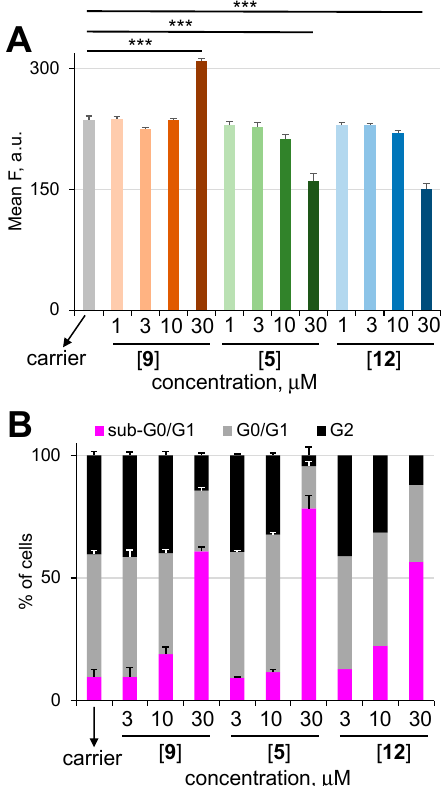
Figure 6. ( A ) E ff ect of prodrug 5 and controls 9 and 12 used at the indicated on the plot concentrations on the intracellular glutathione (GSH) content of viable (Ax-/PI-) Jurkat cells (incubation time: 48 h). Fluorescence intensity corresponding to GSH-sensitive dye monobromobimane is plotted on the OY-axis ( λ ex = 405 nm; λ em = 390–470 nm). ( B ) E ff ect of prodrug 5 and controls 9 and 12 used at the indicated-on plot concentrations (incubation time: 48 h) on cell cycle of Jurkat cells. Student’s t -test: ***— p < 0.001.